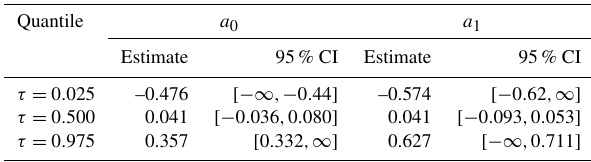
Table 8. Summary of the quantile regression fit of the log- transformed